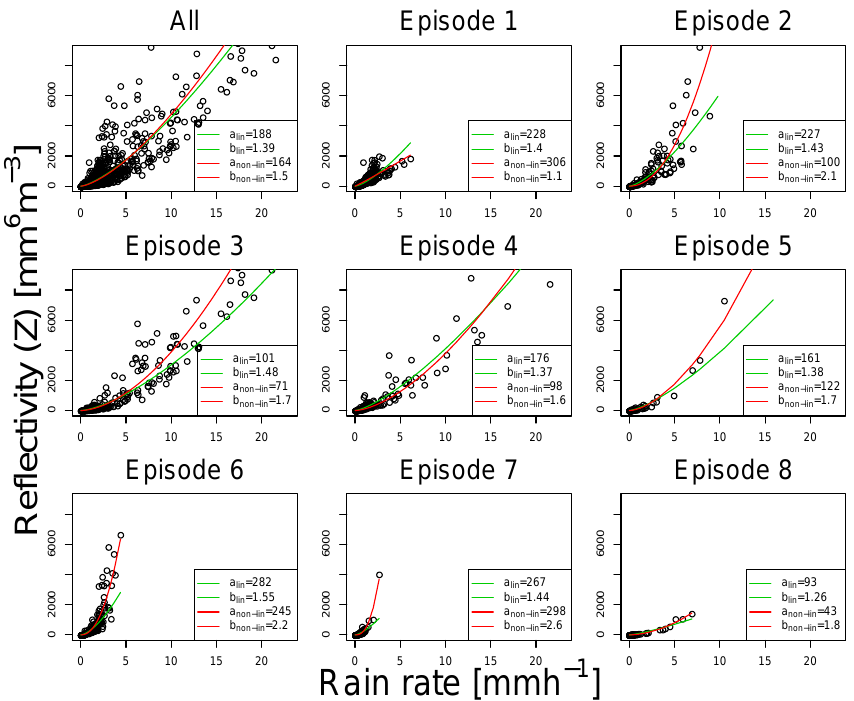
Figure 9. Z – R relations derived from the 1min data of the Parsivel ® for the different rainfall episodes distinguished in Fig. 3 using linear regression on the logarithmic values (green curves) and nonlinear regression (red curves).